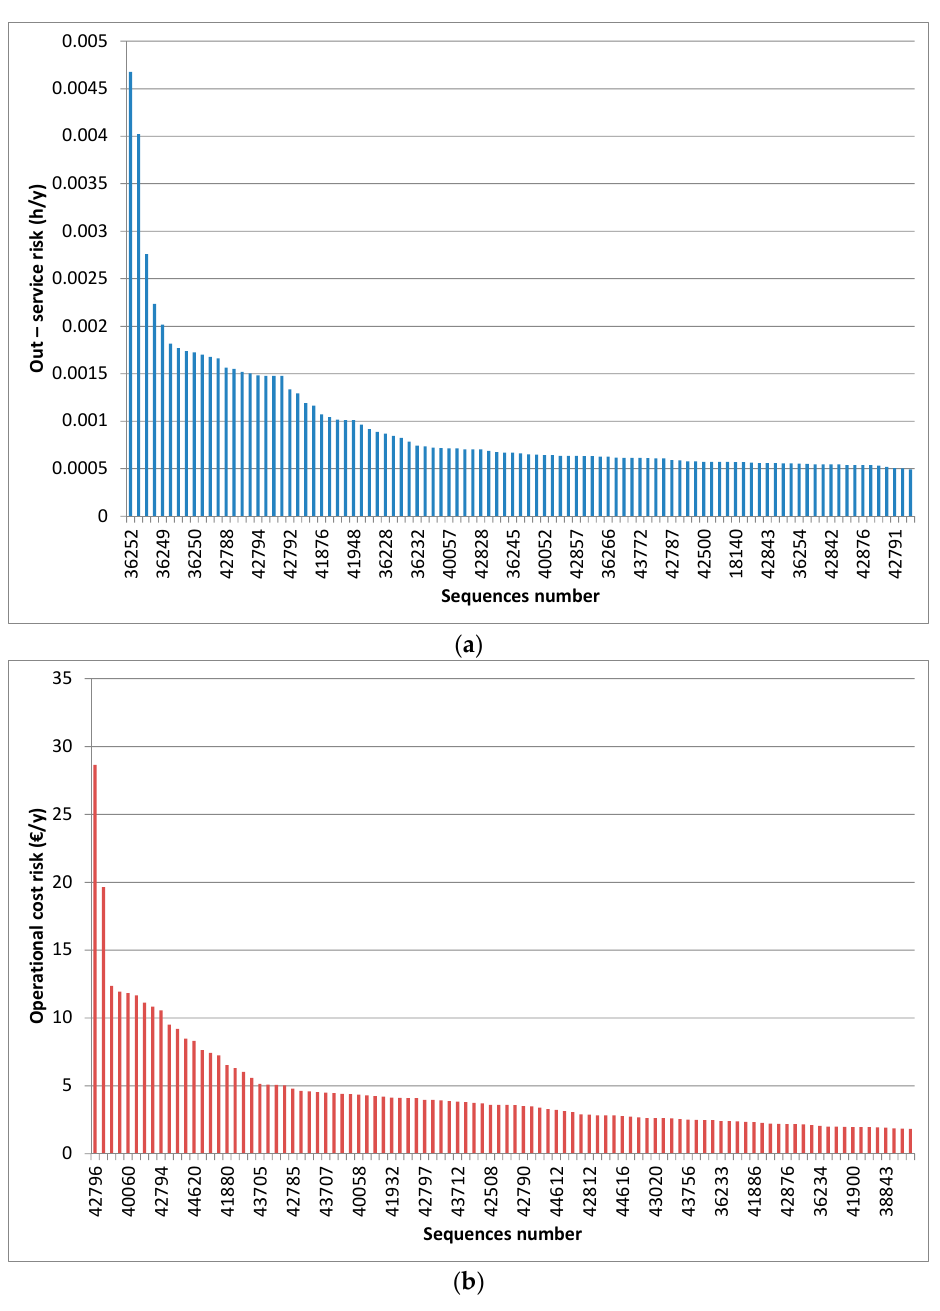
Figure 5. The risk of the sequences of events contain the high concentration of VOCs in the output for the fixed-bed based plant.